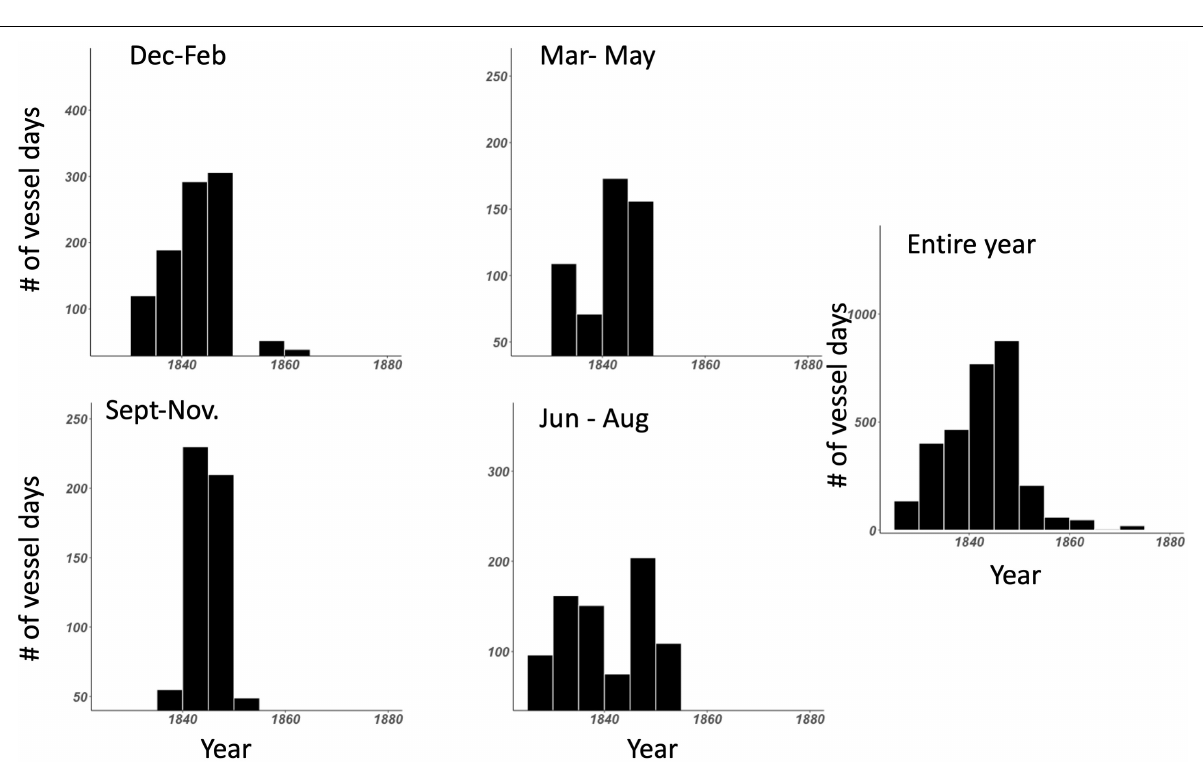
Frontiers in Marine Science |